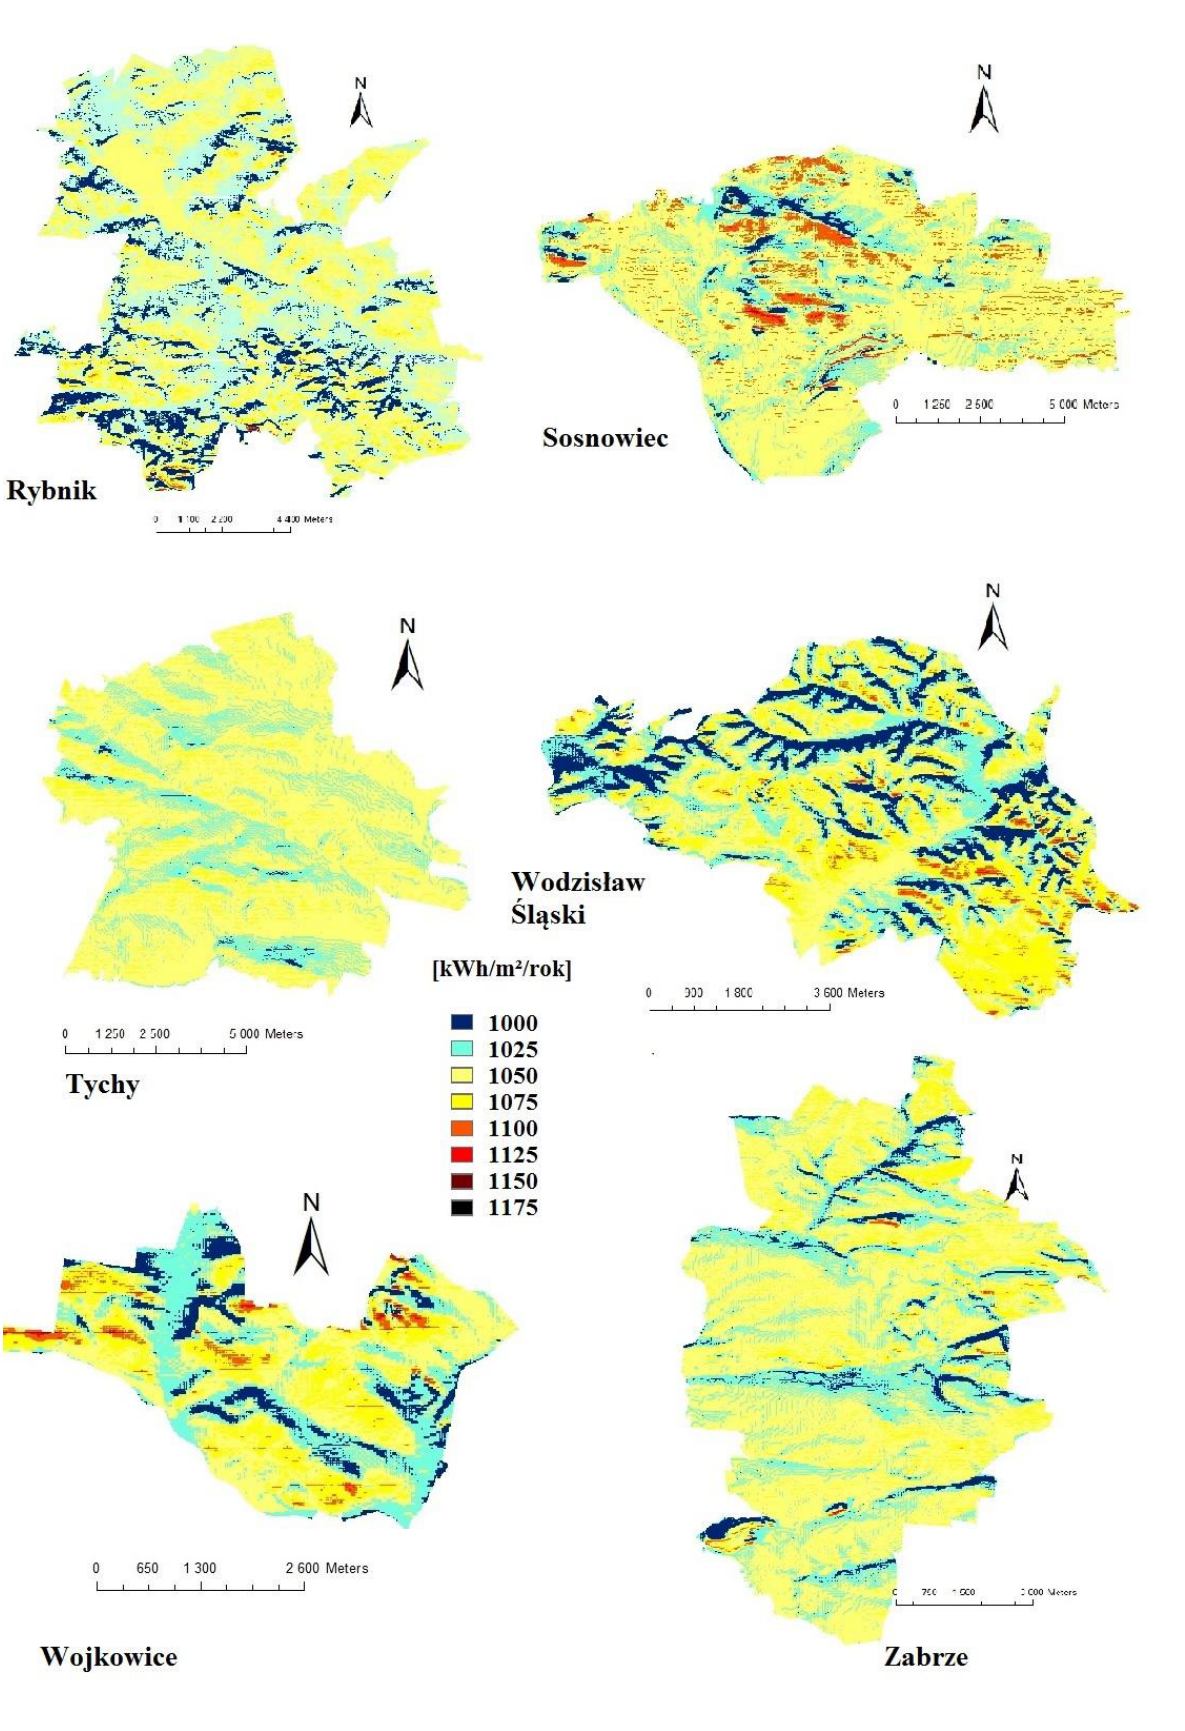
Fig. 5. Theoretical potential of global solar radiation (kWh·m -2 ) in selected districts in the Silesia region